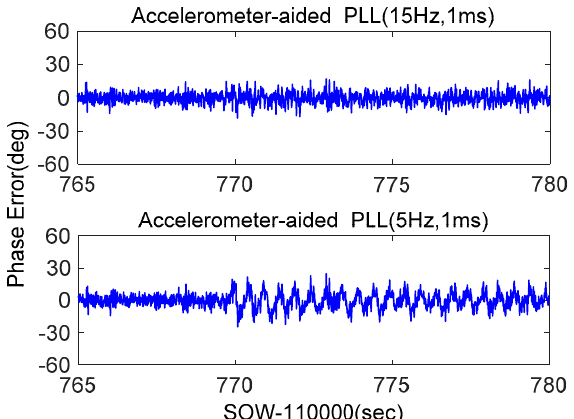
Figure 13. Phase error of accelerometer-aided second-order PLL.